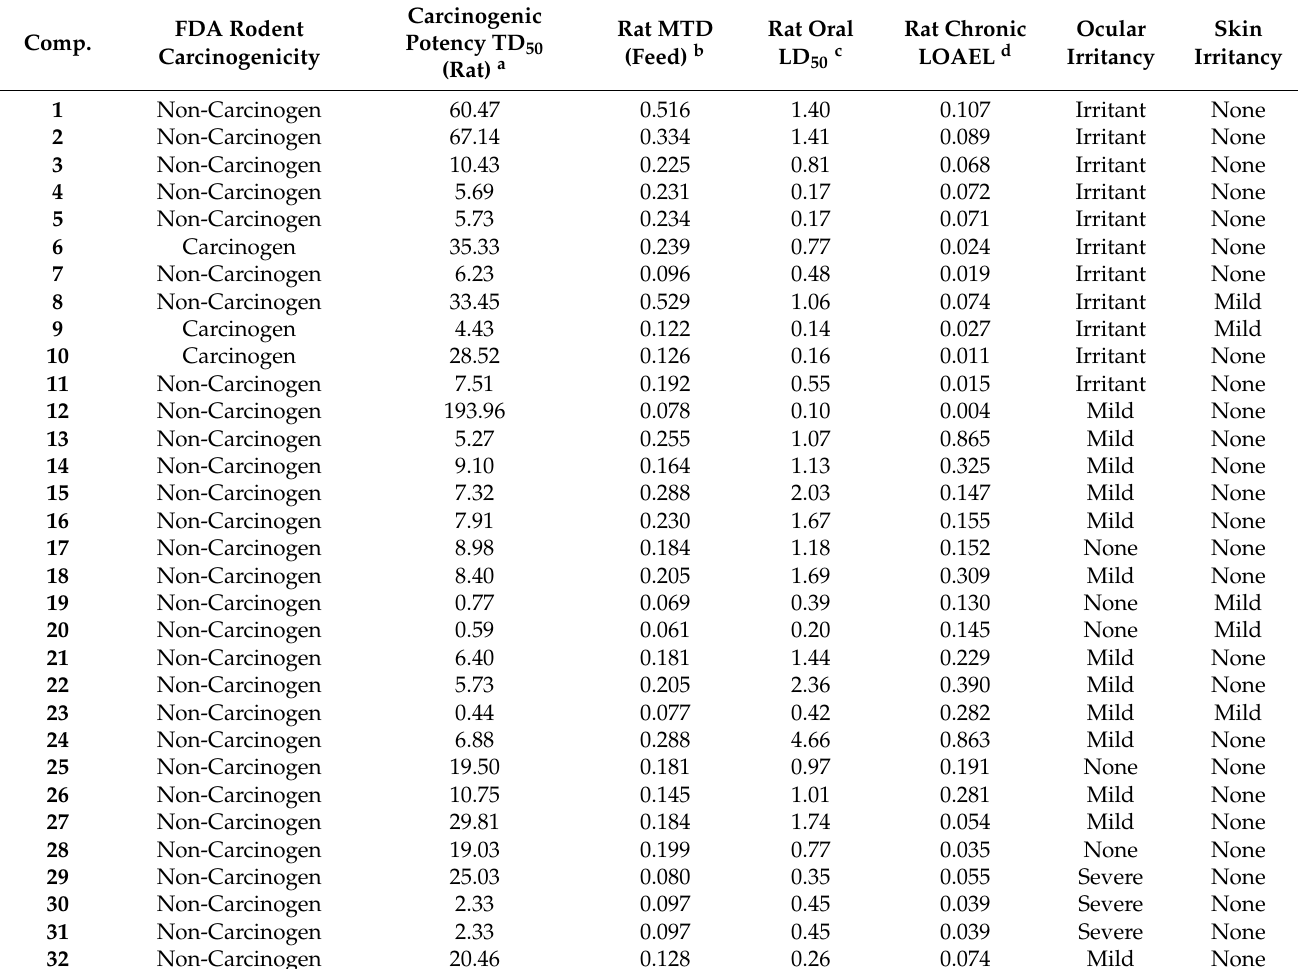
Table 5. Toxicity properties of isoflavonoids ( 1 – 59 ) and